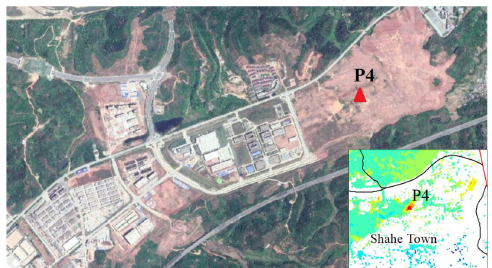
Figure 12. Surface subsidence rate around P1 and P2 and surrounding satellite